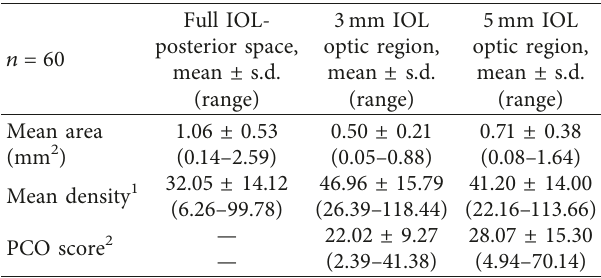
Figure 3: PCO images measured with different methods. The first column shows retroillumination images, the second demonstrates RTVue-100 OCTimages, and the third corresponds to Pentacam images; (a) pseudophakic eye without PCO; (b) fibrosis-like; (c) pear-like, mild; (d) pear-like, middle; (e) pear-like, severe. Table 1: PCO characters (area, density, and score) measured with RTVue-100 OCT.